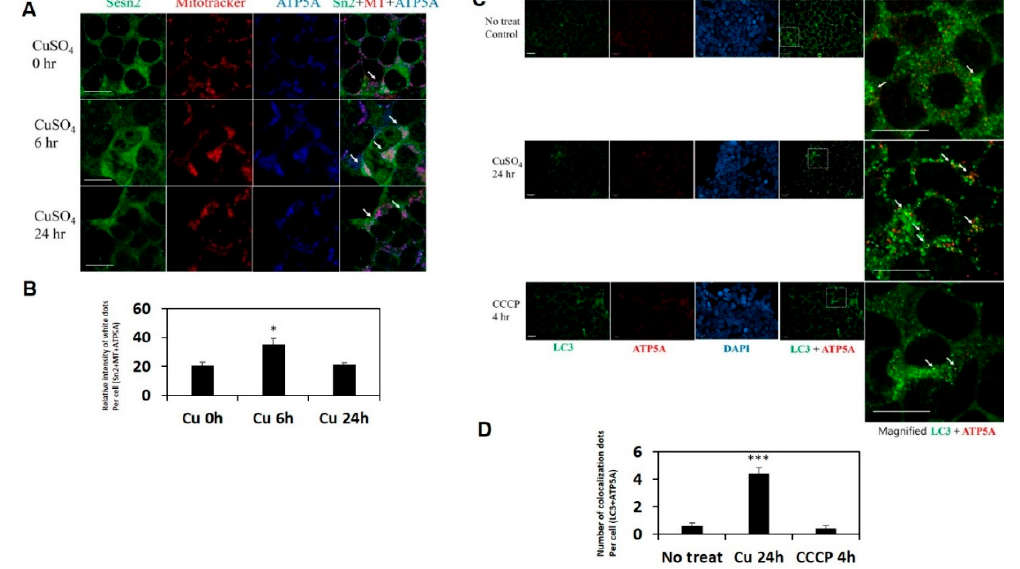
Figure 5. Sestrin2 is strongly colocalized with mitochondria and autophagosomes following Cu toxicity stress. ( A ) HEK293 cells were treated with 500 µ M CuSO 4 for the indicated time in the presence of 100 nM bafilomycin A1 and stained with mitotracker (red) for mitochondria and immunostained with anti-Sestrin2 (green) and anti-ATP5A (blue) antibodies. ( B ) Relative intensity of white dots indicating colocalization between Sestrin2 (Sesn2 or Sn2), mitochondria (MT), and ATP5A was counted by the ImageJ program and quantified as presented in a graph ( n = 5) . ( C ) HEK293 cells were treated with 500 µM CuSO 4 for 24 h or 50 µ M CCCP for 4 h in the presence of pepstatin A and E-64 (10 µg/mL each) and immunostained with anti-LC3 (green), anti-ATP5A (red) antibodies, and DAPI (DNA, blue). ( D ) Number of yellow dots indicating colocalization between LC3 and ATP5A was counted and quantified as presented in a graph ( n = 5) . White arrows indicate the colocalization between indicated fluorescent markers. Data are shown as mean ± s.e.m. * p < 0.05, *** p < 0.001. p - value is from one-way analysis of variance (ANOVA). Scale bars = 200 µm